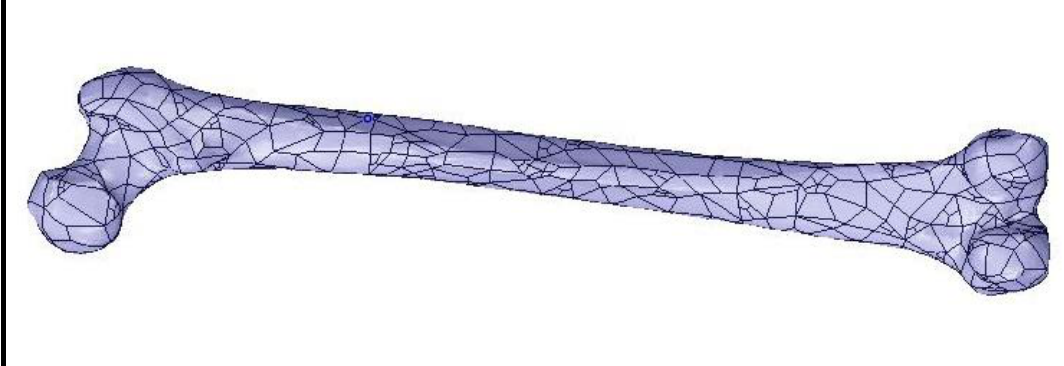
Figure 3. Generated model of an adult right femur. Reprinted from Ref. [21].